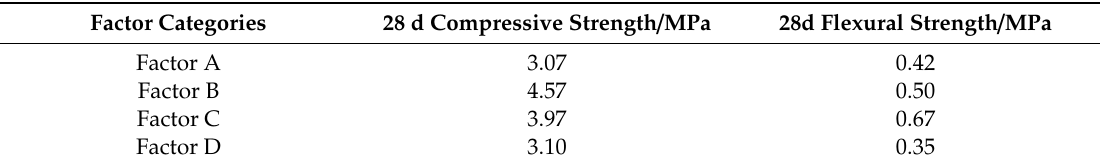
Table 6. Orthogonal Range Analysis of Various Factors Range Analysis.